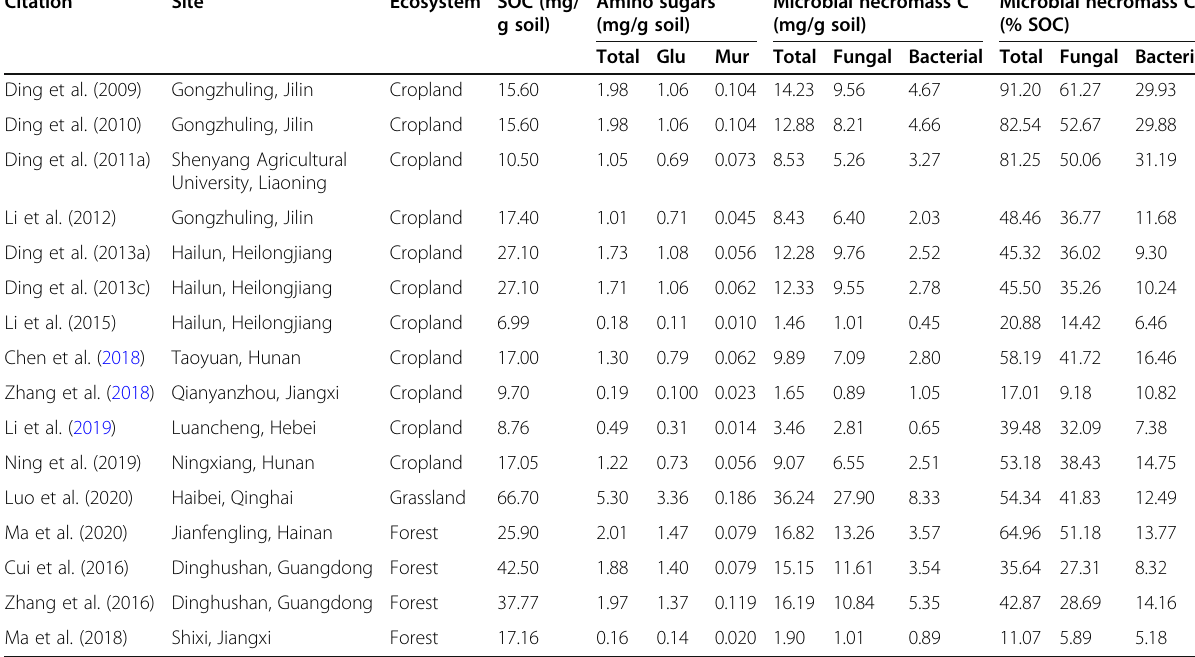
The values are the means of all measurements determined at the study sites. All data were collected at the control plots without N addition. The citations are available in Supplementary Text S1